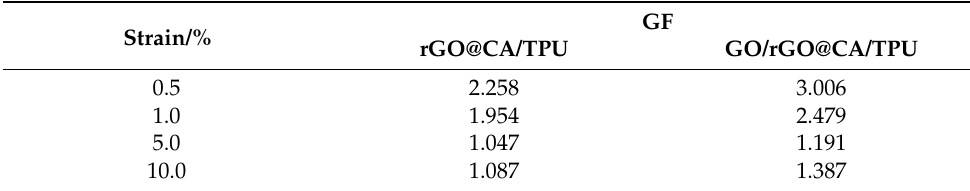
Table 3. The maximum strain sensitivity coefficient of each cellulose ‐ based conductive film with different strain variables.